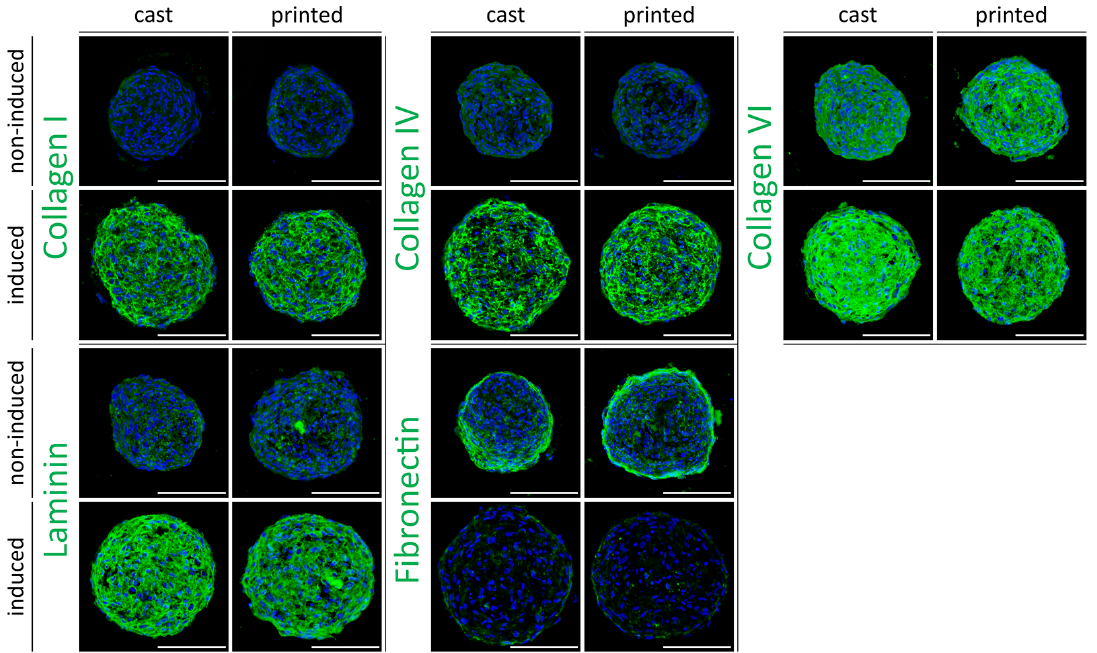
Figure 5. Immunohistochemical analysis of extracellular matrix (ECM) development in ASC spheroids cast and printed in HA–SH/P(AGE-co-G) hydrogels. Immunofluorescence staining of the major ECM components collagen I, collagen IV, collagen VI, laminin, and fibronectin in adipogenically induced vs. non-induced spheroids (day 9). Nuclei were counterstained with DAPI (blue). Scale bars represent 100 µm.